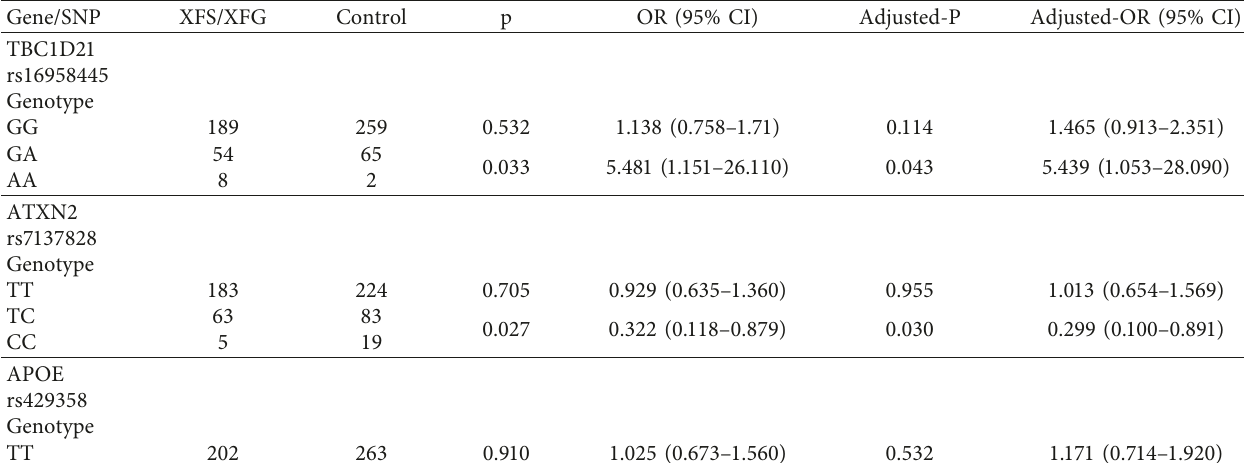
Table 4: Genotype association analysis with these